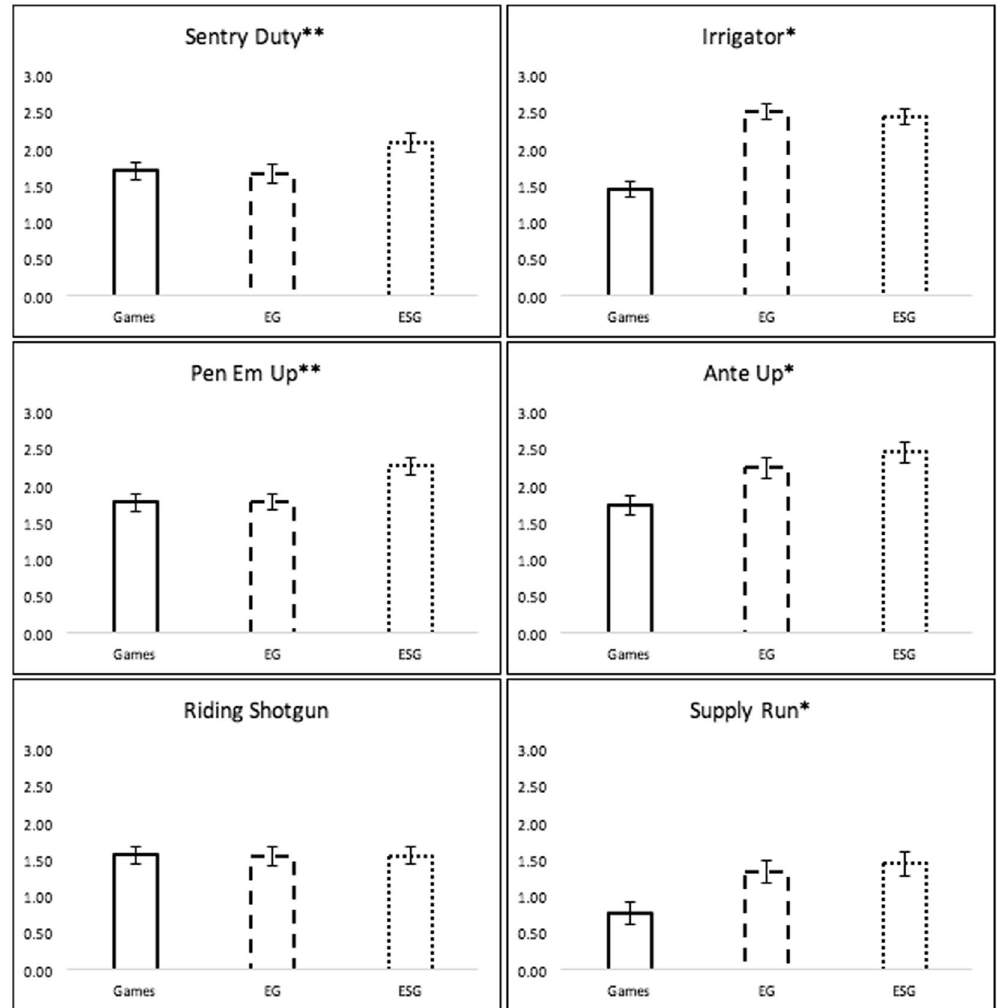
Figure 2. Enhanced Training Performance at Session 20. Standardized improvement units on y-axis. ** Indicates ESG significantly greater than EG and Games (alpha = 0.05); * indicates both ESG and EG significantly greater than Games (alpha = 0.05); no significant effect of group at session 20 for Riding Shotgun. Error bars represent + / − one standard error of the